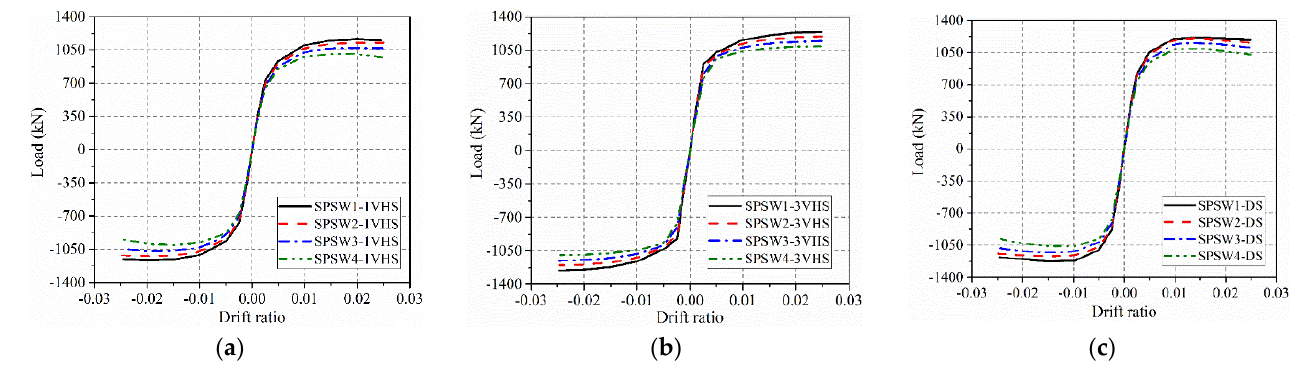
Figure 21. Envelope curves for: ( a ) SPSW − 1VHS, ( b ) SPSW − 3VHS, and ( c ) SPSW − DS with variable column flexural stiffnesses.